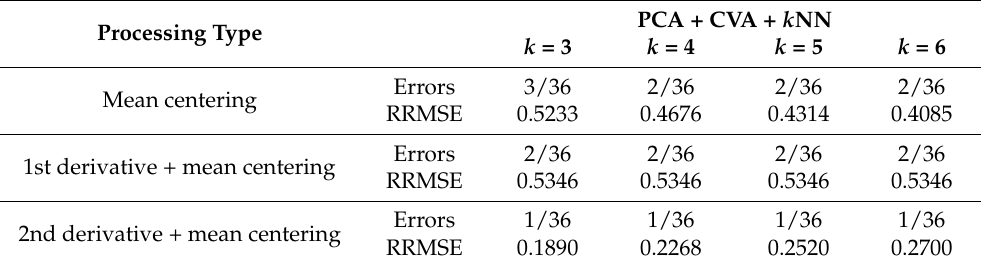
Table 6. Study No. 2 with NIR spectral data. Prediction-set classification errors (36